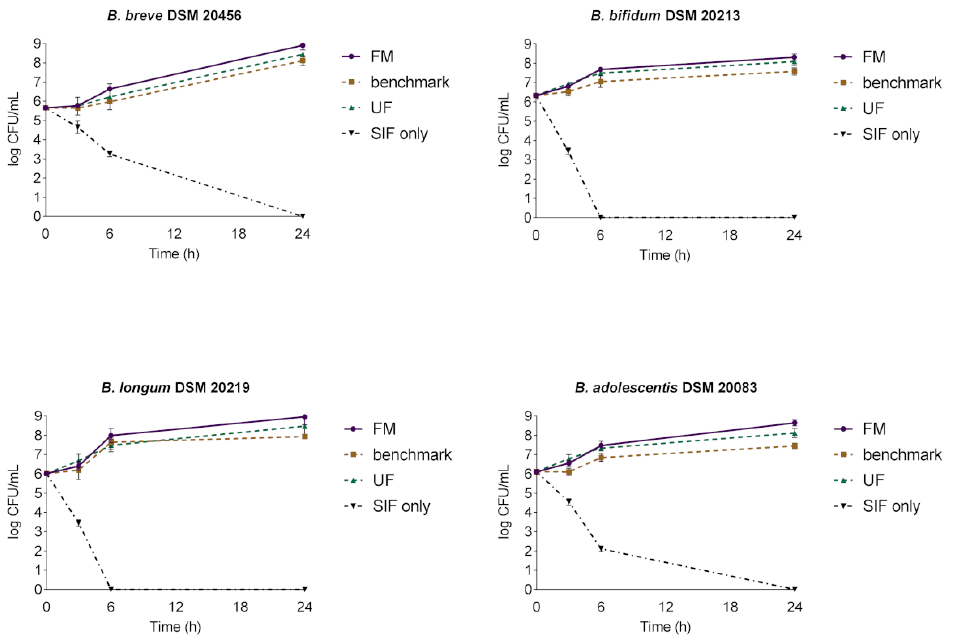
Figure 2. Viability over time of Bifidobacterium spp. in SIF only or in the presence of FM, benchmark and UF (mean ± SD, n = 3).